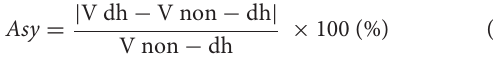
a tablet computer using Bluetooth version 4.0 technology as described by Bakatchina et al.